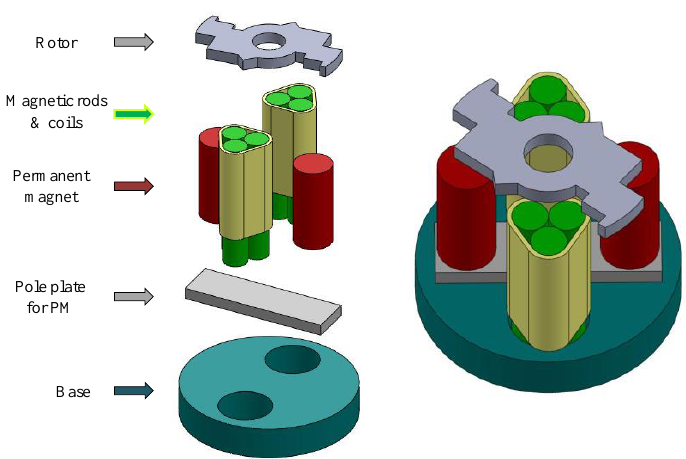
Figure 1. Exploded view and assembly drawings of the micro, axial-flux, single-phase switched reluctance motor.